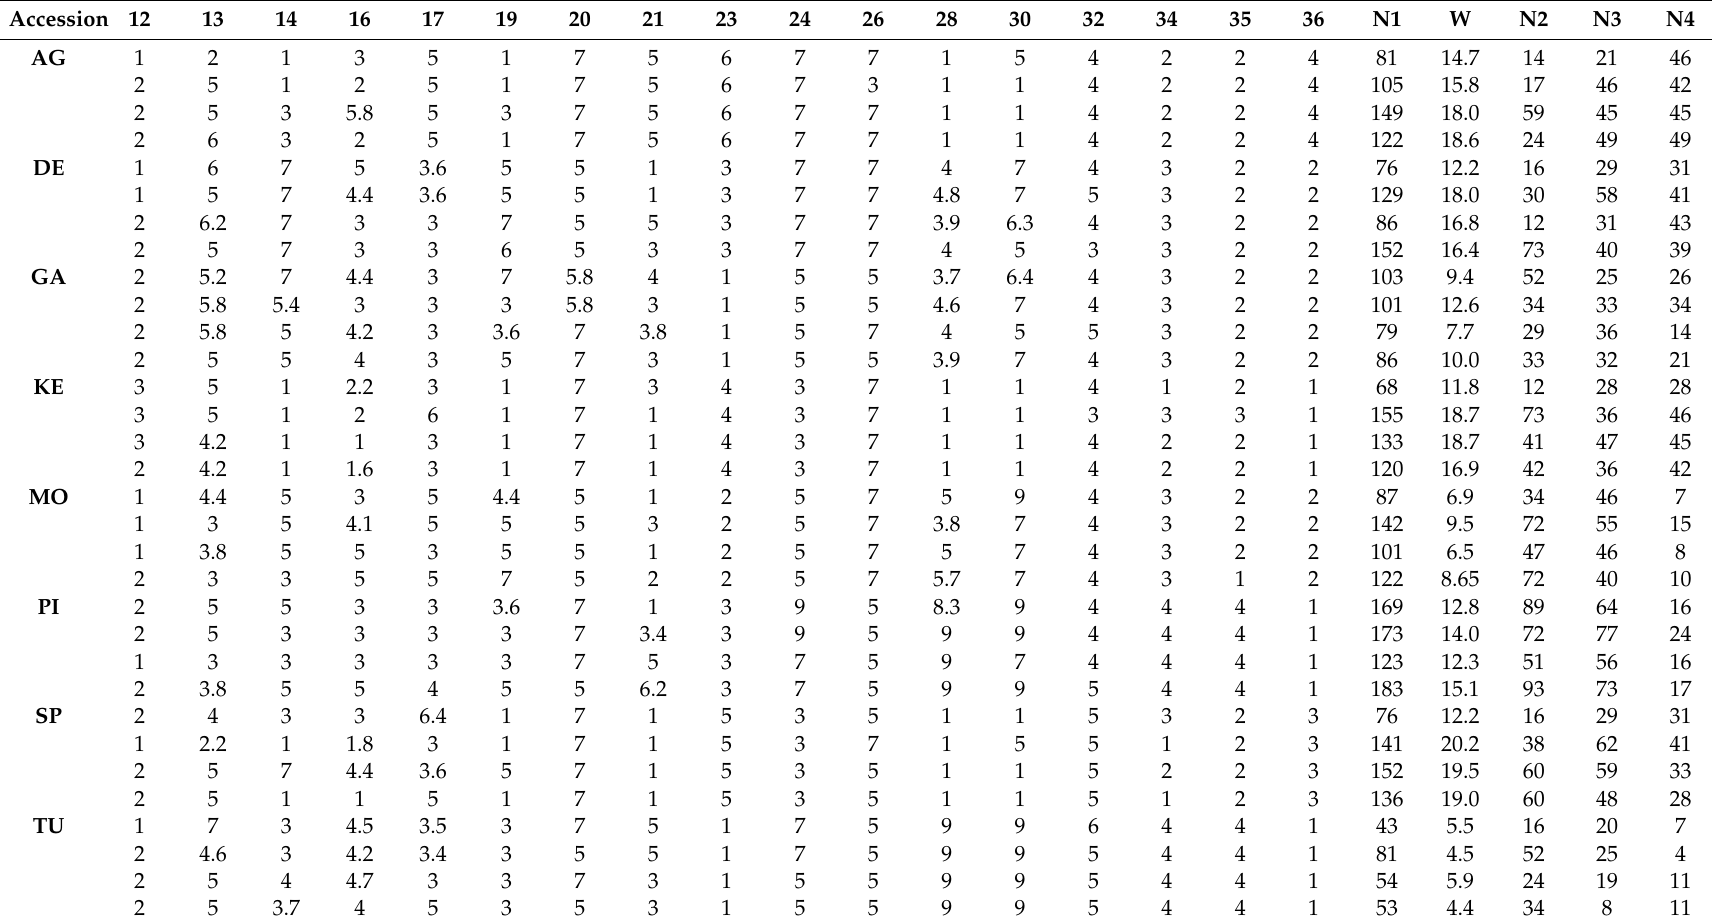
Table A1. Values of the morpho-agronomic descriptors defined in Table 1 for the eight potato